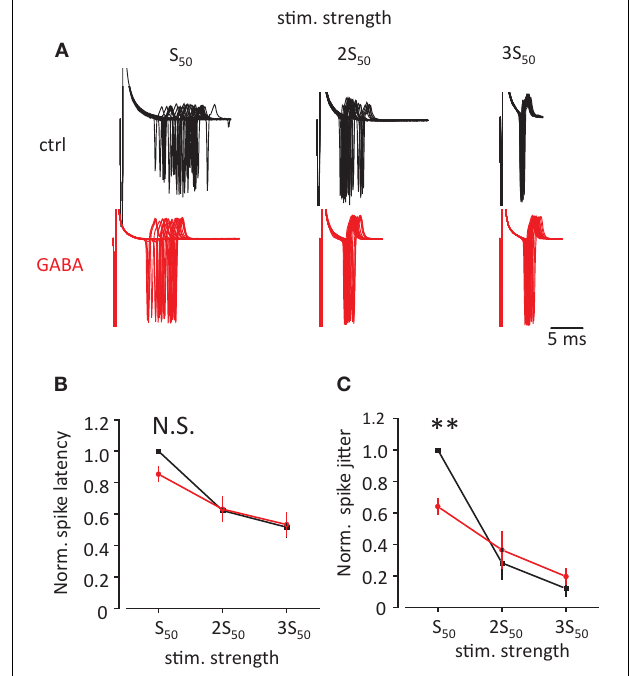
FIGURE 5 | Effect of GABA on spike latency and spike jitter in response to stimulation of Schaffer collaterals. (A) Sample traces of cell-attached recordings in voltage clamp showing action currents triggered by stimulation of Schaffer collaterals in control conditions (black) and in the presence of GABA (red). First, the stimulation was adjusted to obtain approximately 50% success rate (S 50 ). Then it was increased 2 and 3 times (2S 50 and 3S 50 ). (B,C) Normalized spike latency (B) and spike jitter (C) in control conditions (black) and in the presence of GABA (red). Data presented as mean ± s.e.m. (error bars). N.S. p > 0 . 05; ∗∗ P < 0 . 01; paired t